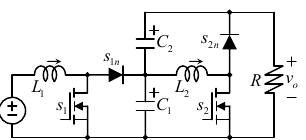
Figure 1. The multistage-stacked boost architecture (MSBA) converter.